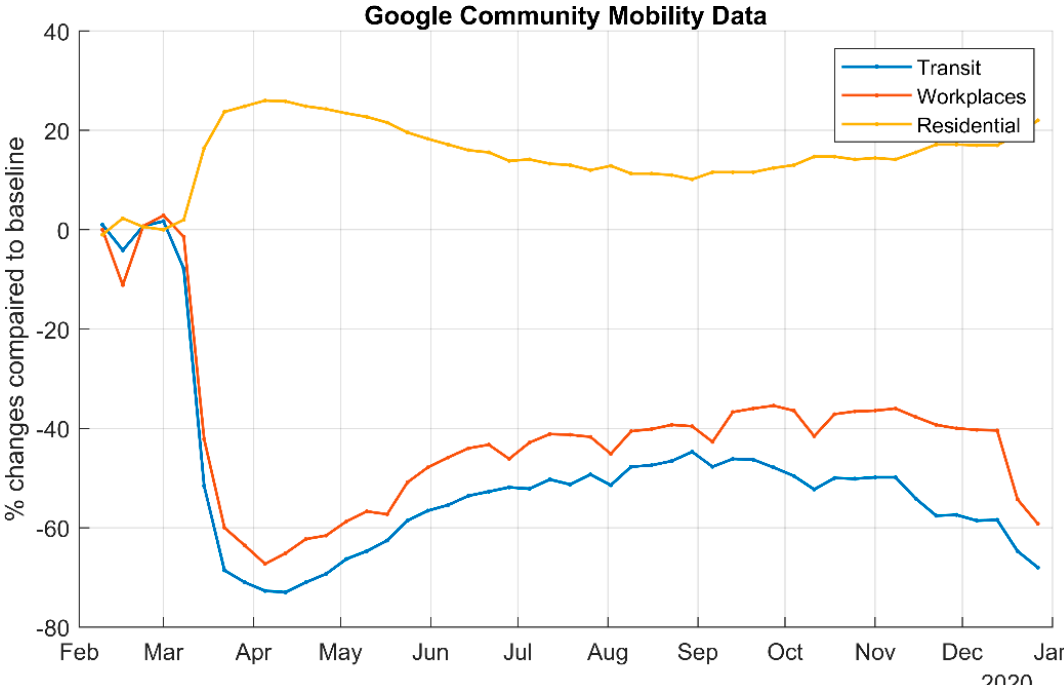
Figure A4. Weekly averaged percentage mobility changes in Toronto (2020). Data from Google Community Mobility Report (© Google).